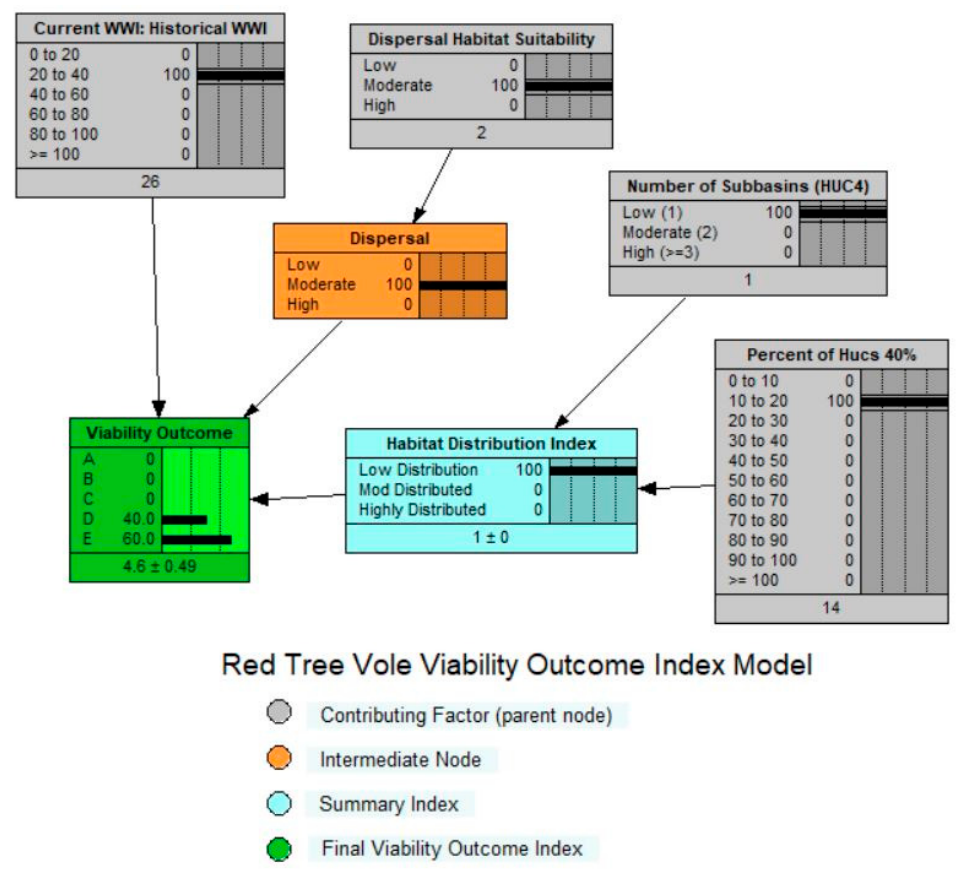
Figure 5. Red tree vole ( Arborimus longicaudus ) viability outcome index model for the evaluation area in Oregon and California, USA (with sample application).